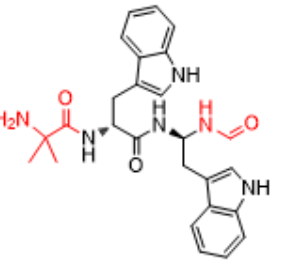
Figure 6. Structure of macimorlein. Modifications with respect to a tripeptide are shown in red.